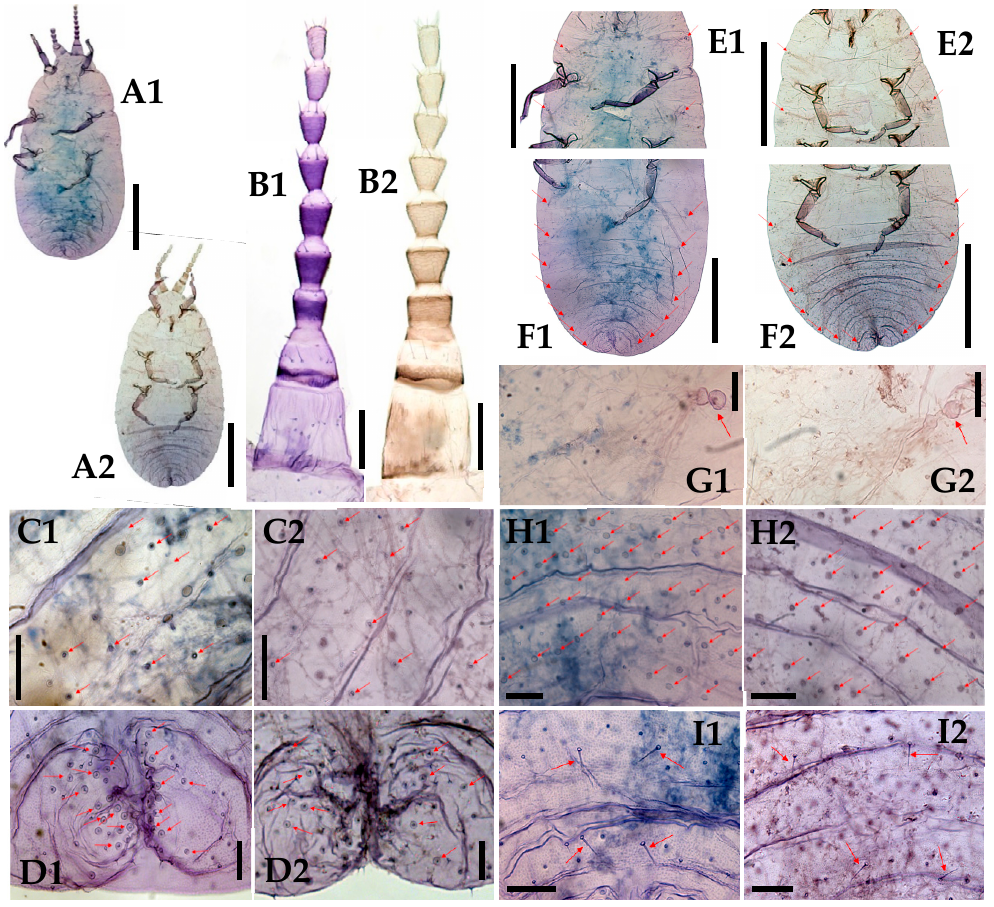
Figure 4. Morphological comparison of the adult females from Goheung (first) and Fukuoka (second). A , bodies; B , antennae; C , bilocular tubular ducts; D , multilocular disc-pores; E , thoracic spiracles; F , abdominal spiracles; G , spiracles with numerous tracheae; H , cicatrices; I , ventral setae on abdomen. Scale lines for A, E, F = 1 mm; B = 100 μ m; C, D, G, H, I = 50 μ m